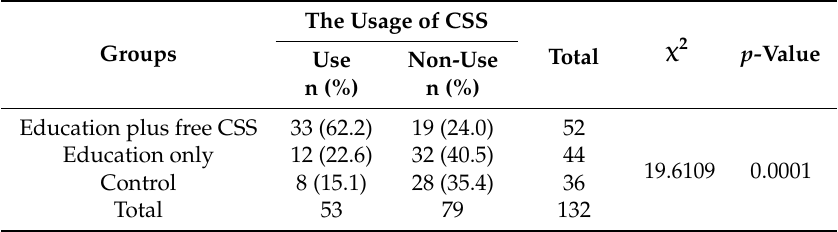
Table 2. The usage of child safety seat (CSS) in three groups among parents of newborns.